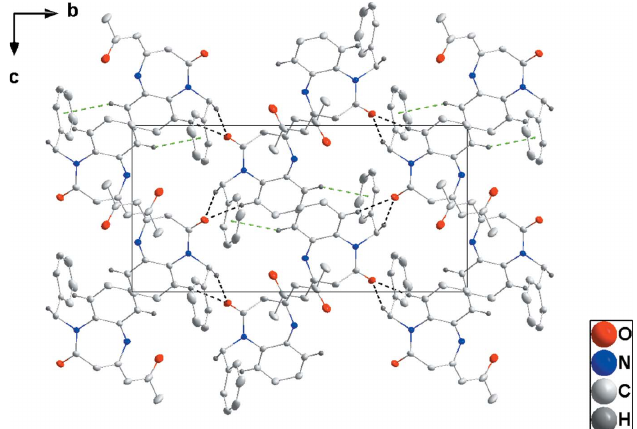
Figure 3 Packing viewed along the a -axis direction with intermolecular inter- actions depicted as in Fig. 2.